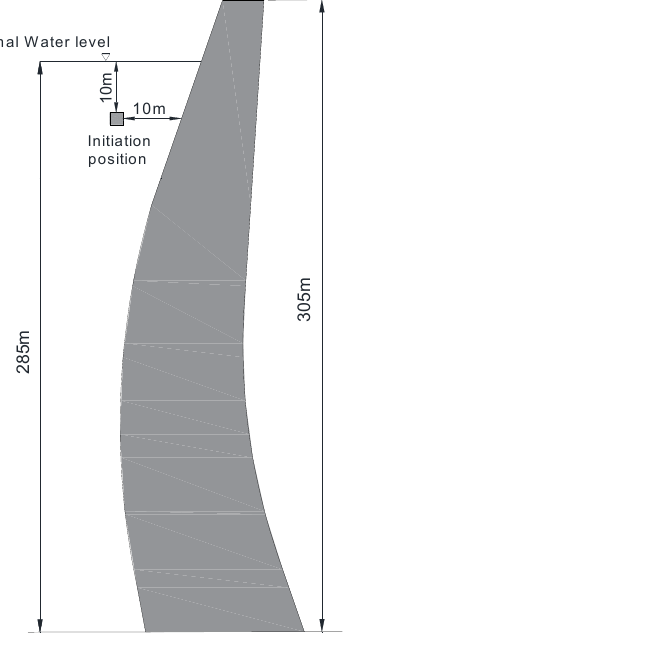
Figure 10. Position of detonation at various explosive equivalents.